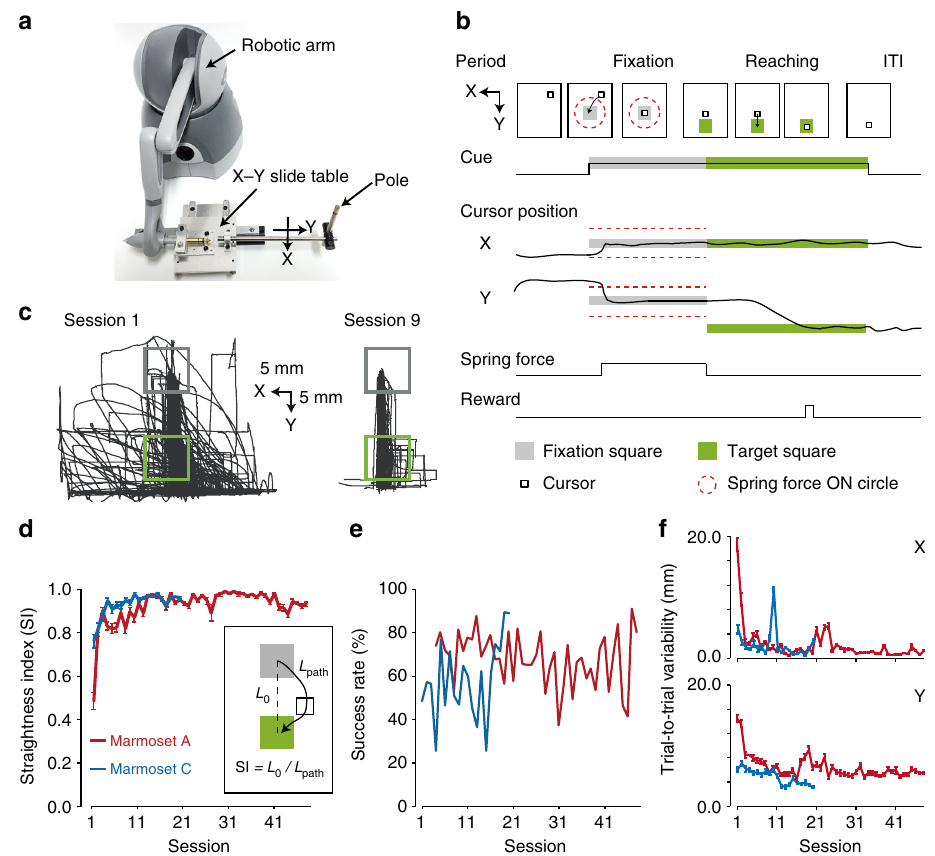
Fig. 3 Learning of the one-target reaching task. a An X – Y slide table to enable marmosets to control the pole on a 2D working space (53 mm for the X-axis and 90 mm for the Y-axis). A robotic arm was connected to the table. b The task consisted of fi xation and reaching periods, and an inter-trial interval (ITI). During the reaching period, a target (green) was presented and marmosets used the manipulandum to move the cursor from a fi xation square (gray) to the target and hold it for 10 – 300 ms to obtain a reward. c Reaching trajectories in sessions 1 and 9 in marmoset A. Each trajectory for each trial is overlaid. Gray and green boxes indicate the fi xation and target squares, respectively. d Time course of the mean straightness index (SI) of the successful reaching trajectory in marmosets A (red) and C (blue). CCs between SI and the training session were 0.48 (0.45 without the initial session) for marmoset A ( P < 0.01) and 0.70 (0.65 without the initial session) for marmoset C ( P < 0.01). e Time course of the success rate. The success rate was calculated by dividing the number of rewarded trials by that of all trials. The success rate in marmoset C was relatively low until session 15, because marmoset C had dif fi culties in stopping and holding the cursor within the target square, and the cursor frequently passed through it, even though the trajectory became straighter. f Time course of the trial-to-trial variability (see Methods) of X (top) and Y (bottom) coordinates for the successful reaching trajectories in marmosets A (red) and C (blue). The CCs between mean of the root mean square deviations (RMSDs) of X and Y coordinates and the session number in marmoset A were − 0.58 ( – 0.55 without the initial session) and − 0.55 ( – 0.52 without the initial session), respectively, P < 0.01, while for marmoset C they were − 0.44, P = 0.054 ( – 0.36 without the initial session, P = 0.12), for the X coordinate, and − 0.85 ( – 0.83 without the initial session), P < 0.01, for the Y